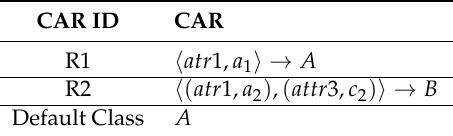
Table 6. All CARs from ECARG.